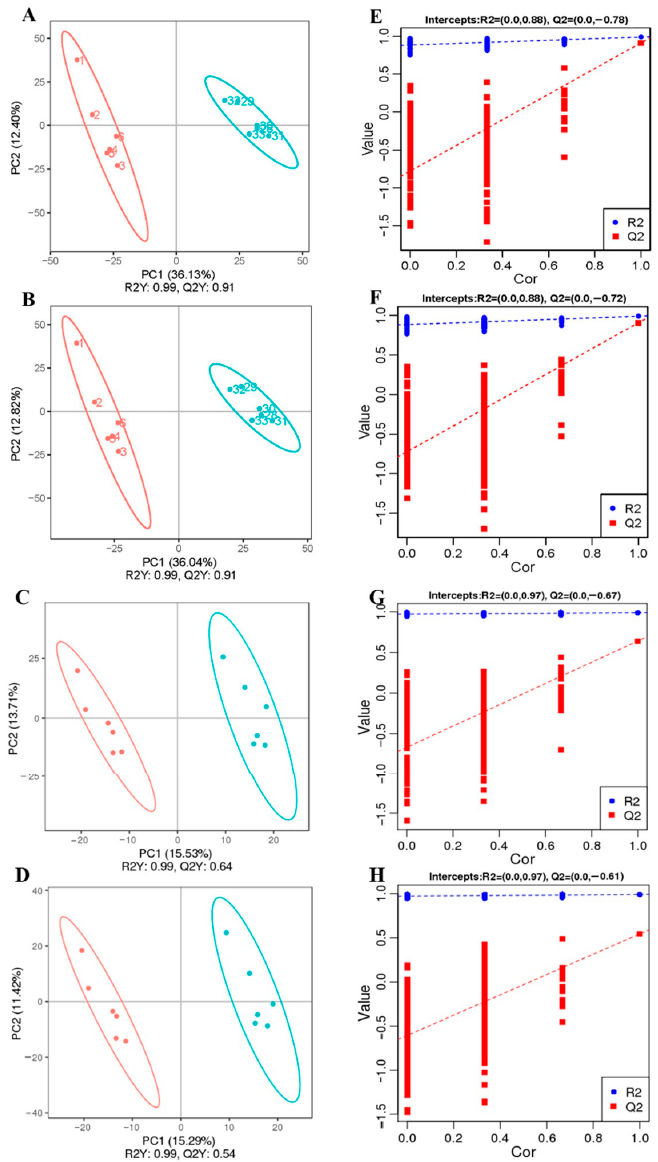
Figure 4. Partial Least Squares Discriminant Analysis (PLS-DA) analysis of intestinal contents. ( A ) PLS-DA scores plots depicting obvious difference between the Lactobacillus rhamnosus GG (LGG)-1 group and the natural recovery (NR)-1 group in positive ion mode. ( B ) PLS-DA scores plots depicting obvious difference between the LGG-1 group and the NR-1 group in negative ion mode. ( C ) PLS-DA scores plots depicting obvious difference between the LGG-2 group and the β -CG group in positive ion mode. ( D ) PLS-DA scores plots depicting obvious difference between the LGG-2 group and the β -CG group in negative ion mode. ( E ) Sorting verification chart depicting obvious difference between the LGG-1 group and the NR-1 group in positive ion mode. ( F ) Sorting verification chart depicting obvious difference between the LGG-1 group and the NR-1 group in negative ion mode. ( G ) Sorting verification chart depicting obvious difference between the LGG-2 group and the β -CG group in positive ion mode. ( H ) Sorting verification chart depicting obvious difference between the LGG-2 group and the β -CG group in negative ion